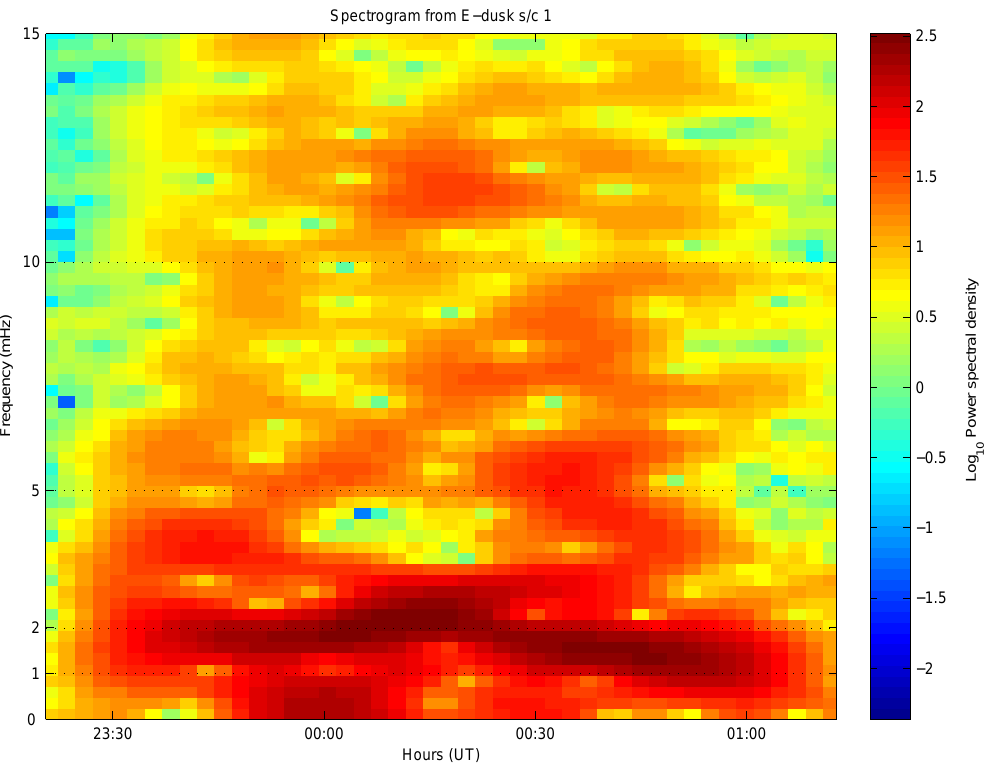
Fig. 5. Spectrogram calculated from the duskward electric field component from s/c